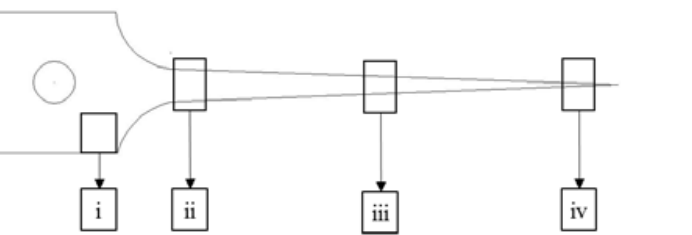
Figure 2. The schematic diagram of the sample locations cut from the tensile test samples: (i) at the grip position, (ii) at the gauge section near the grip, (iii) at the middle of the gauge section, and (iv) near the tip of the fracture.